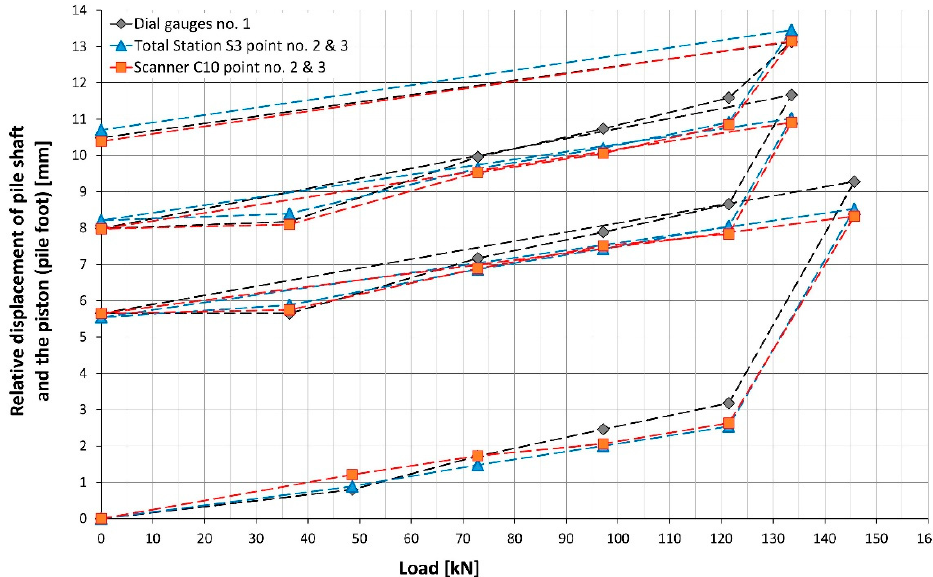
Figure 15. The relative displacement of pile shaft and the piston (pile foot) calculated for a pair of checkpoints no. 2 and no. 3.